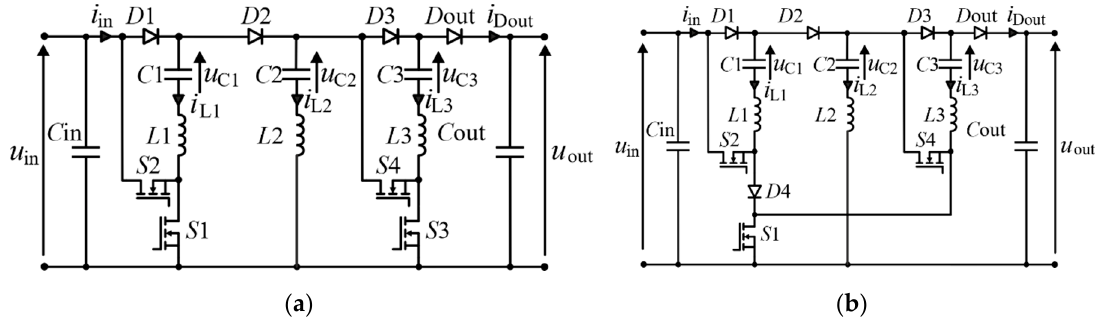
Figure 1. Proposed new resonant converters with low count of switches and common input/output negative point: ( a ) LCSCVMa, ( b ) LCSCVMb.